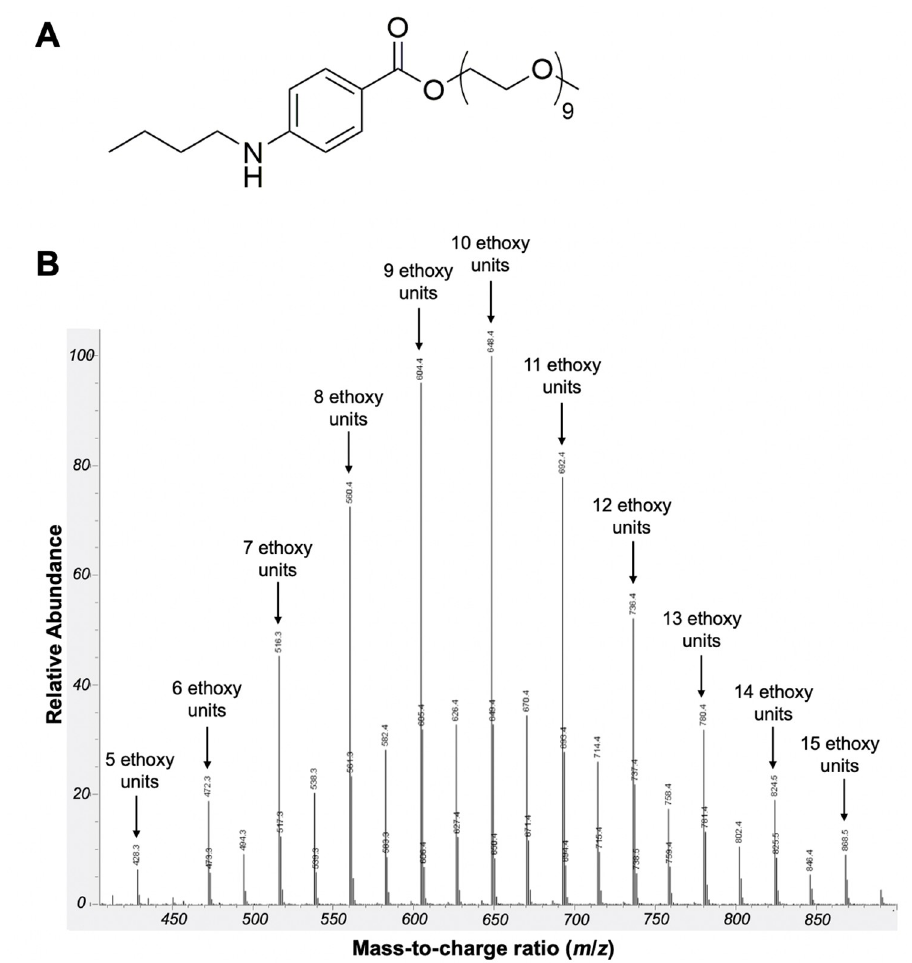
Fig 1. Characterization of benzonatate. (A) chemical structure of benzonatate (B) LC-MS of benzonatate used in this study.